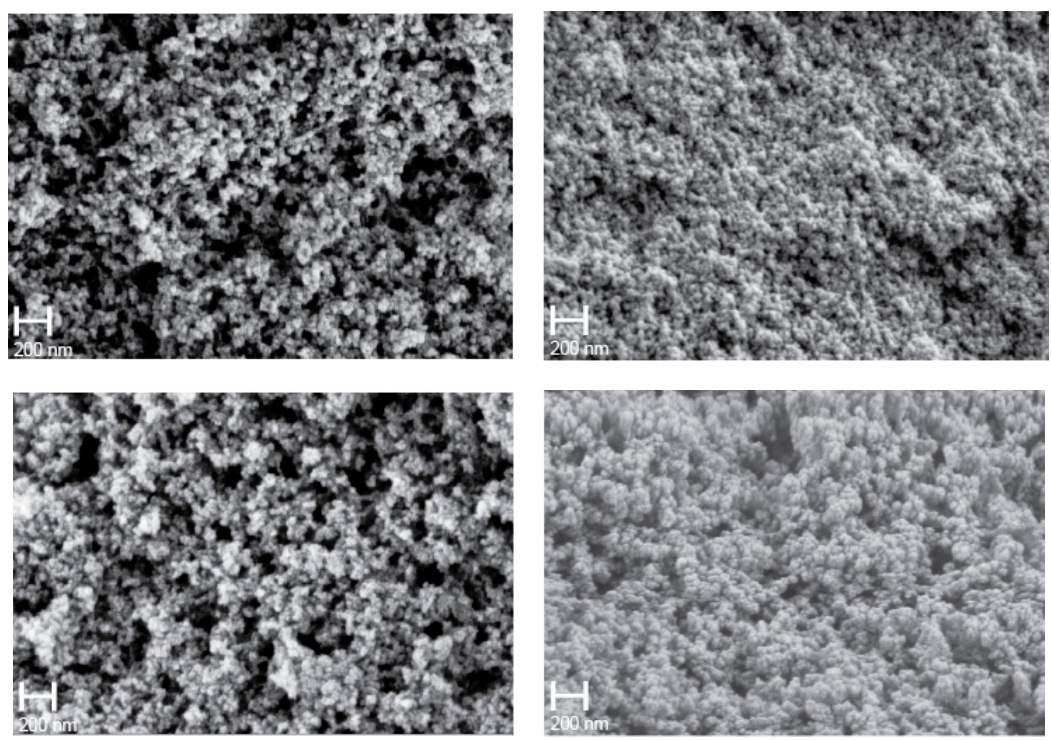
Figure 2. FE-SEM micrographs of PMHS/DVB polymer aerogels synthesized in cyclohexane ( top left ), tetrahydrofuran ( top right ), acetone ( bottom left ), and n-hexane ( bottom right ). All pictures were obtained using the same magnification (100 k).